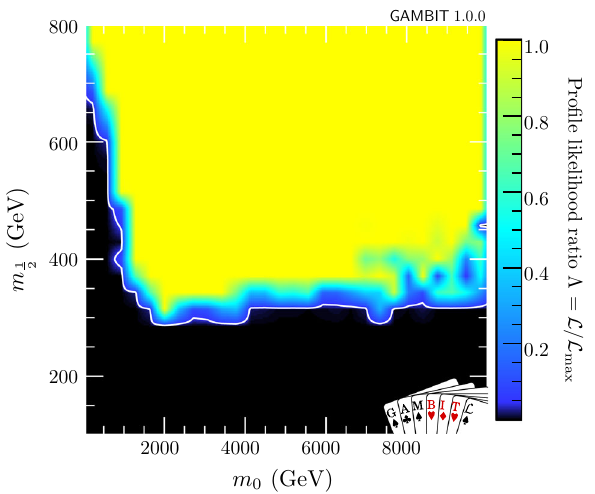
Fig. 5 Output from a ColliderBit CMSSM scan over m 0 , m 1 / 2 , tan β , and A 0 , with SM parameters set to default values, using Diver with GAMBIT production settings ( convthresh = 10 − 5 and NP = 19200). ThelikelihoodincludesalloftheATLASandCMSRunIanalysessum- marised in the text, but no other contributions. The colour map shows the profile likelihood ratio L / L max and the solid white line indicate the GAMBIT 95% CL exclusion contours at L / L max = 0 .